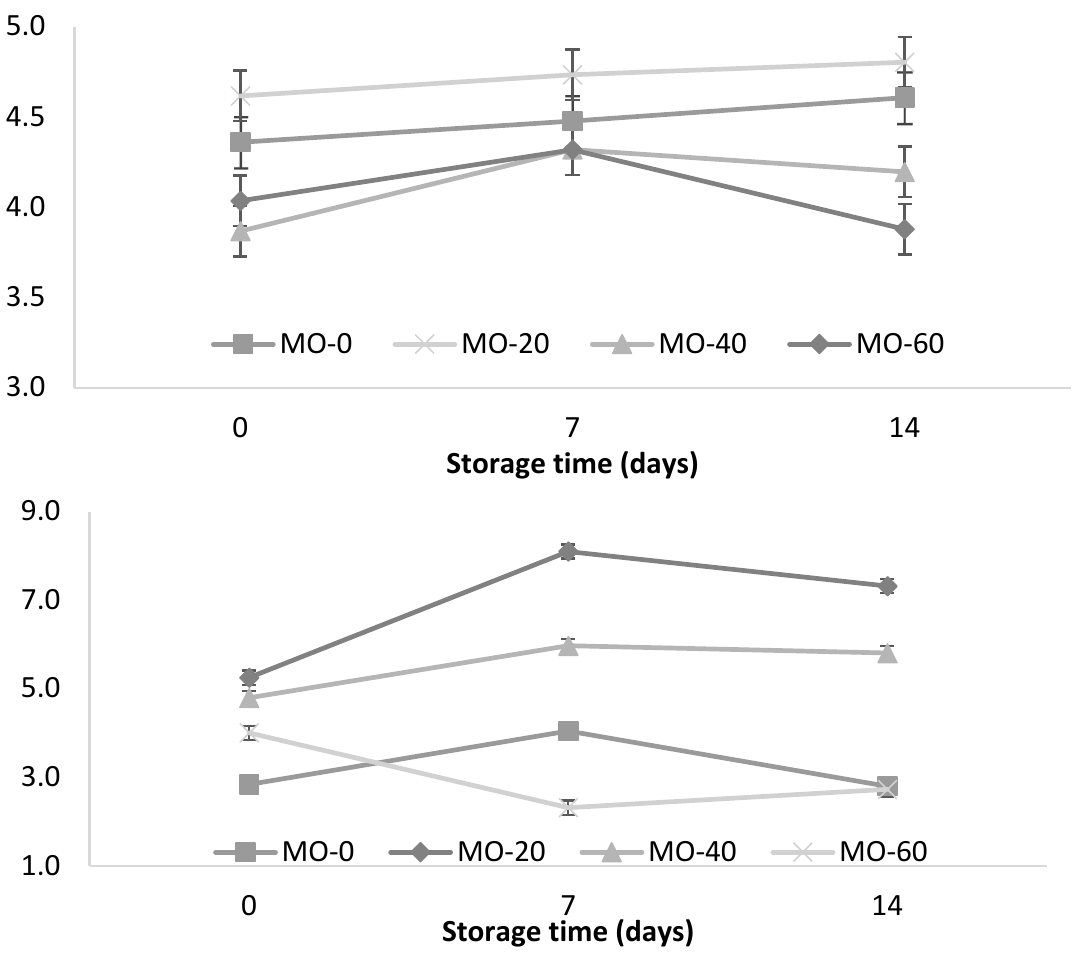
Figure 1. Storage changes in pH and acidity of yogurt from sheep fed with Moringa oleifera extracts. Bars denote standard error of the means.